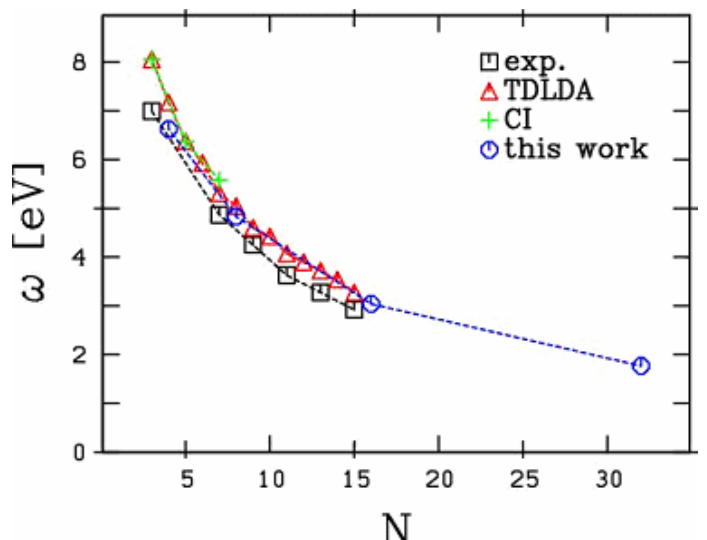
Figure 2 . Systematics of the longitudinal mode in small carbon chains. Comparison is performed between experiments [19] and [20], and various calculations: TDLDA from [21], quantum chemistry (CI) calculations from [17] and [18].